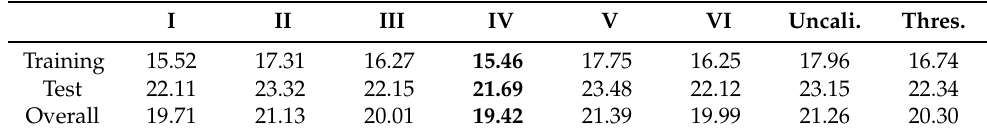
Table 2. Absolute Error ( × 10 − 3 cm 3 /cm 3 ) Between SMAP SM and Retrieved SM Using Calibrated and Uncalibrated Data.